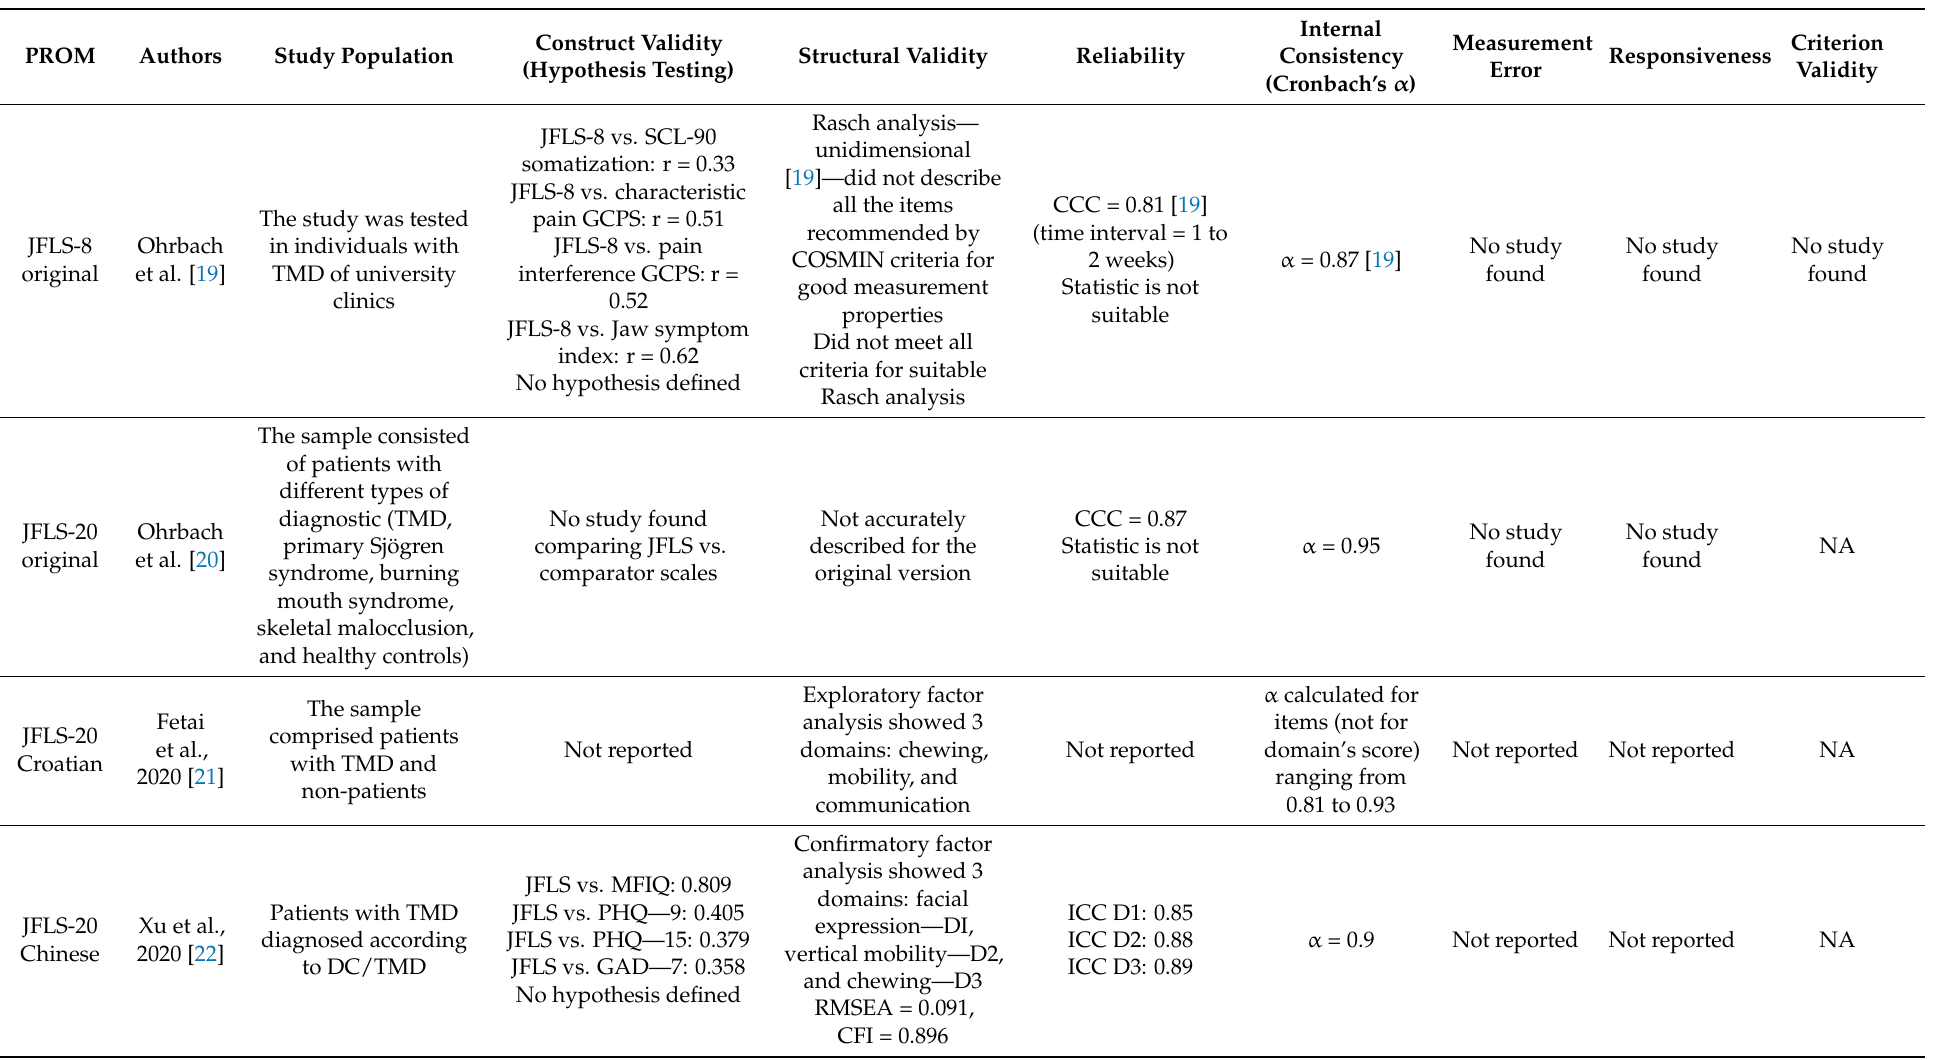
Table 3. Summary of the measurement properties of each Jaw Functional Limitation Scale (JFLS)